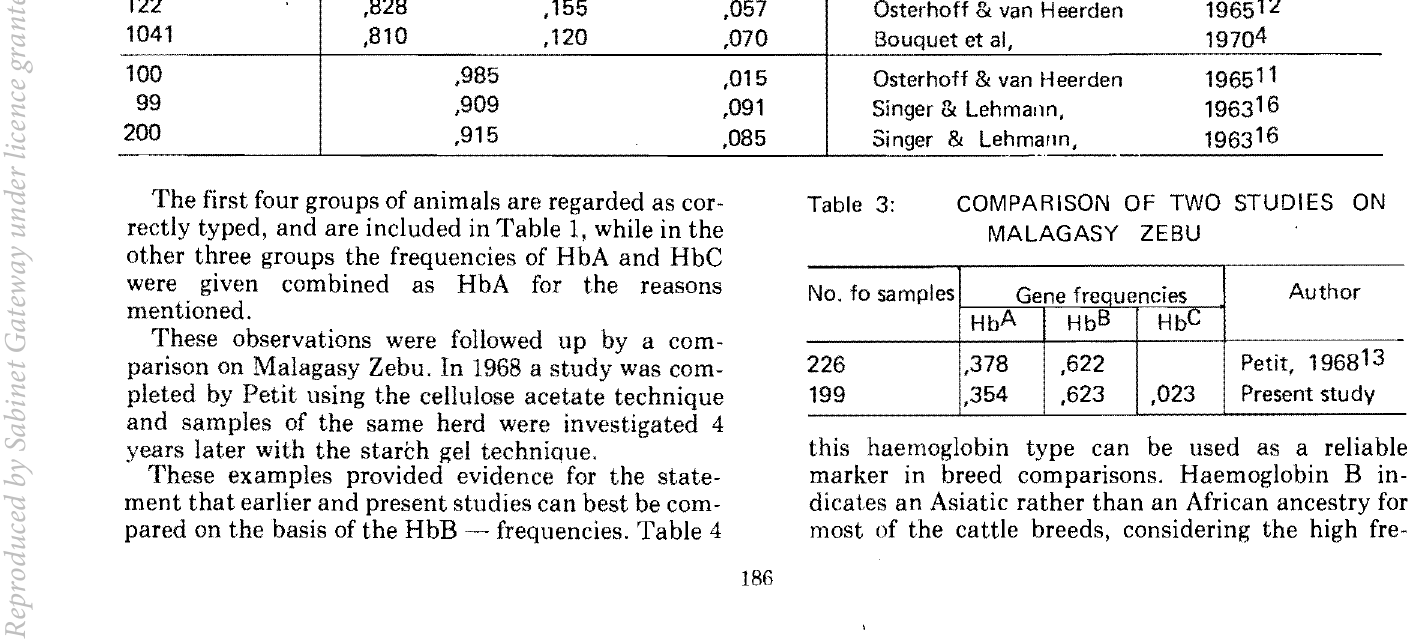
COMPARISON OF SEVERAL STUDIES ON AFRIKANER CATTLE. Gene frequencies